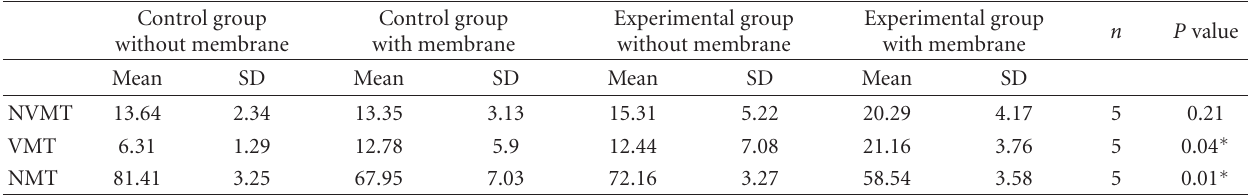
Table 2: Mean and standard deviation of the non-vital mineralized tissue (NVMT), vital mineralized tissue (VMT), and non-mineralized tissue (NMT), analyzed by histomorphometrics, in percentage (%). P values < 0.05 were marked ( ∗